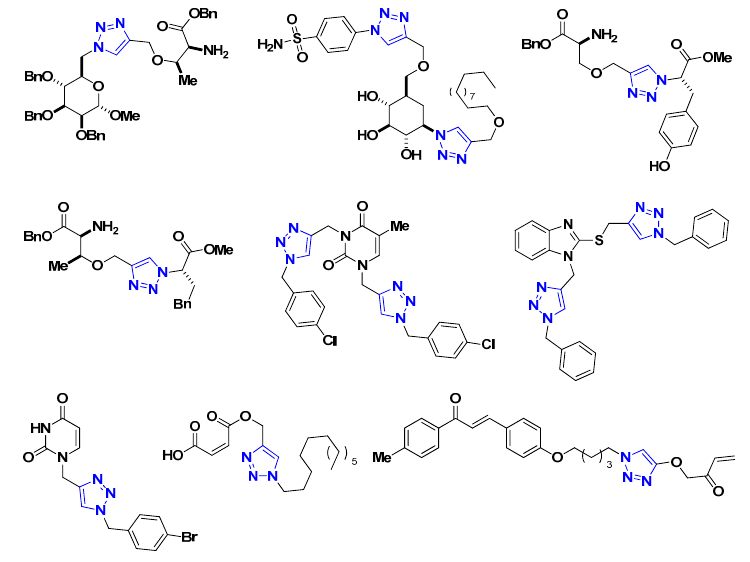
Figure 1. Representative 1,2,3-triazoles with corrosion inhibition activity.